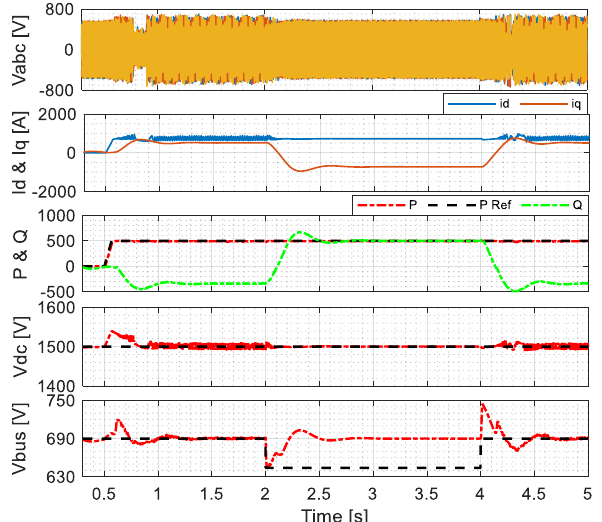
Figure 8. Real and reactive power supply results.